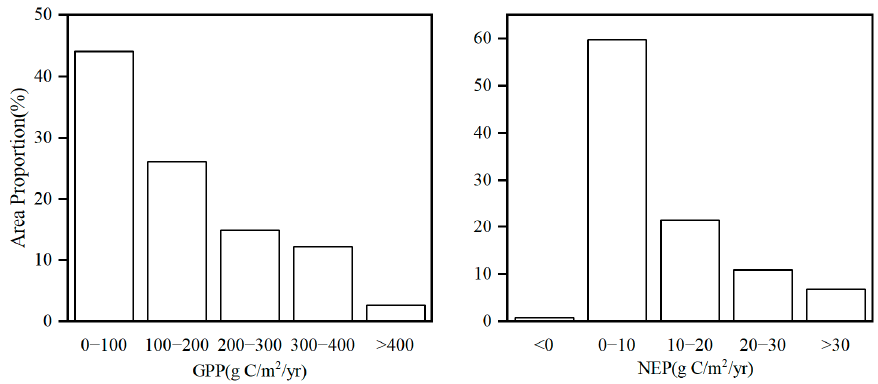
Figure 6. Area proportion of the different carbon flux distribution intervals.